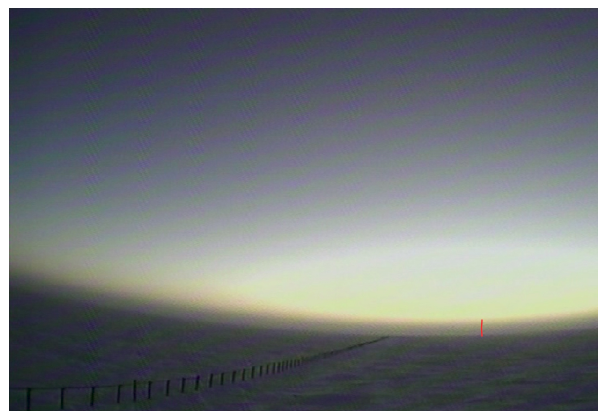
Figure 1. Webcam image of the ice fog at 12:00UTC (20:00LT) on 8 March 2018 at Dome C. The shallow and thin fog layer manifests as a thin dark band above the horizon (delimited with a red